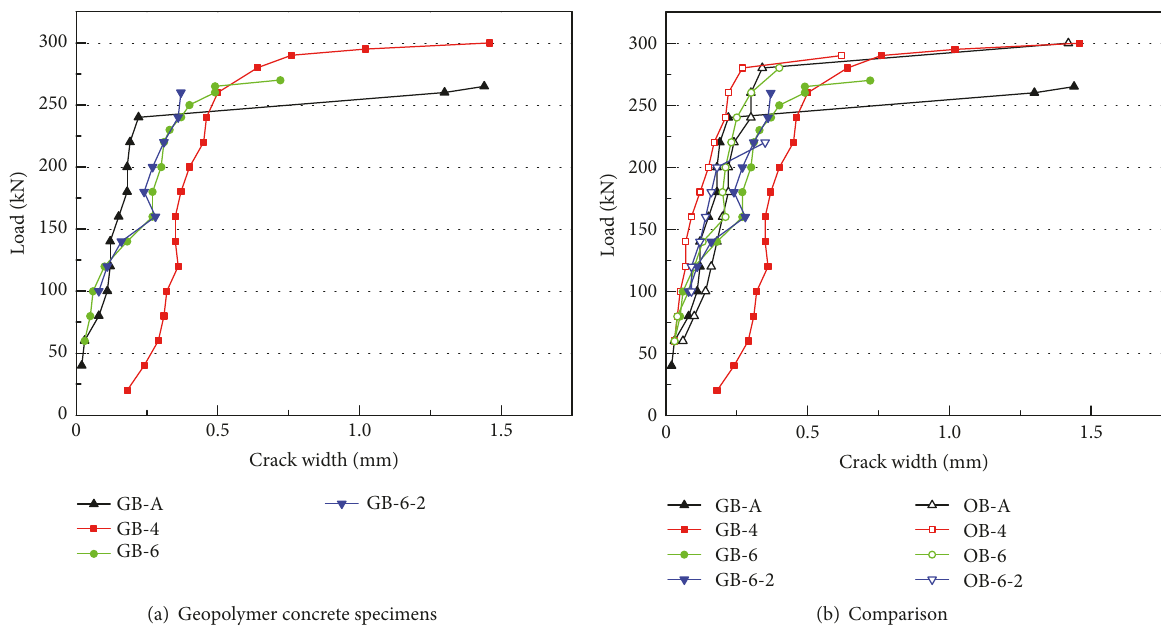
Figure 4: Load-crack width